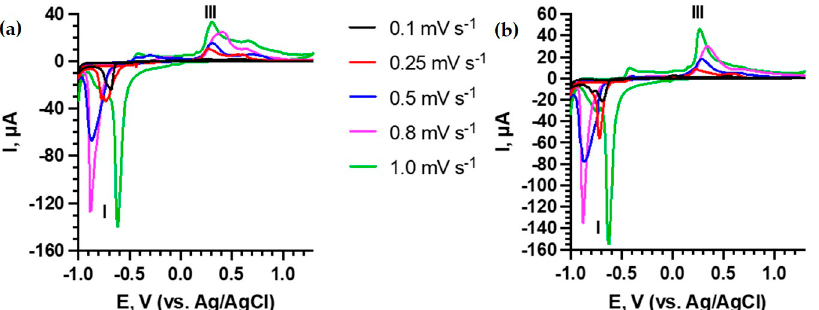
Figure 6. CVs for Bi 2 Se 3 thin films with various scan rates (0.1—1.0 mV s − 1 ): ( a ) 2nd cycle; ( b ) 3rd cycle.